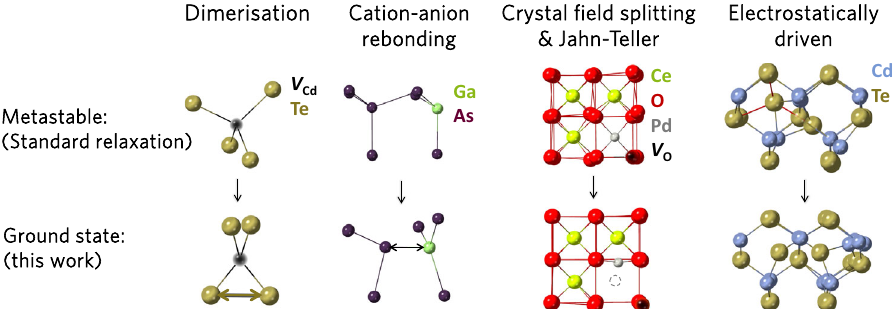
Fig. 3 Types of symmetry-breaking reconstructions at point defect sites identi fi ed by our method: dimerization, cation-anion rebonding, crystal fi eld splitting and Jahn-Teller, and electrostatically driven. The high-symmetry (metastable) and symmetry-broken (ground state) structures are